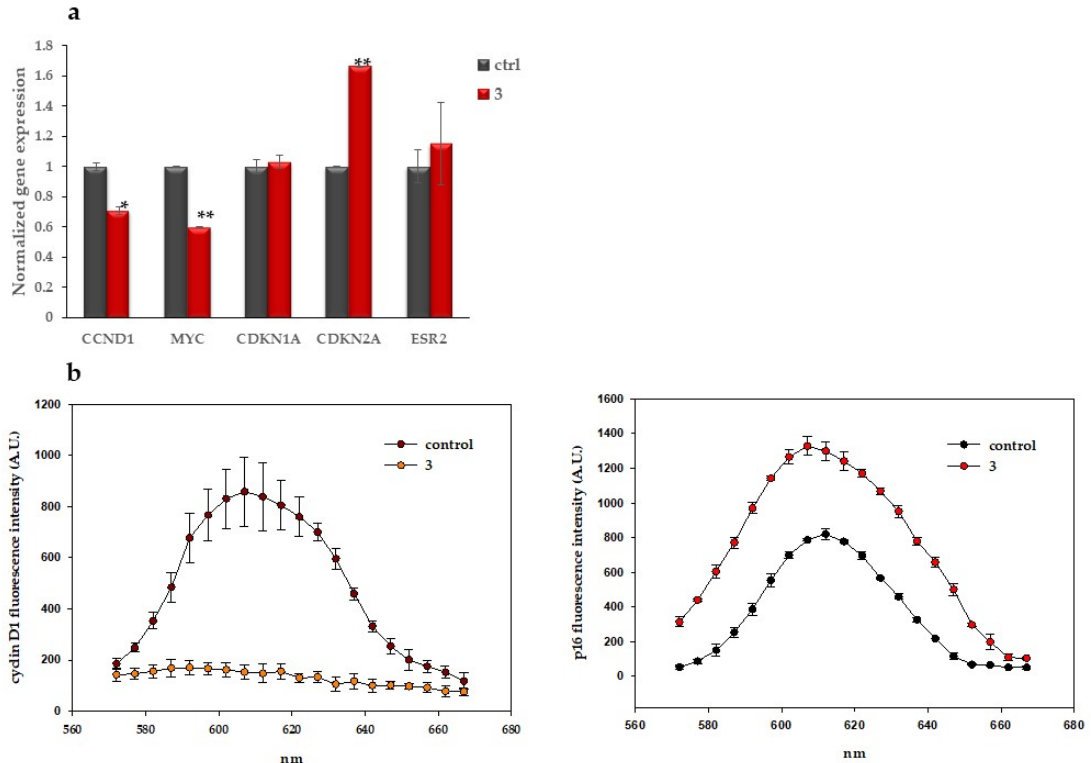
Figure 6. Compound 3 modifies gene and protein expression: ( a ) gene expression for CCND1, MYC, CDKN1A, CDKN2A, and ESR2 analyzed by RT-PCR after 6 h of treatment; and ( b ) fluorescence spectra of cyclin D1 (left) and p16 (right) under 568 nm laser excitation. Data shown are the result of five separate experiments. * p < 0.05, ** p < 0.01.